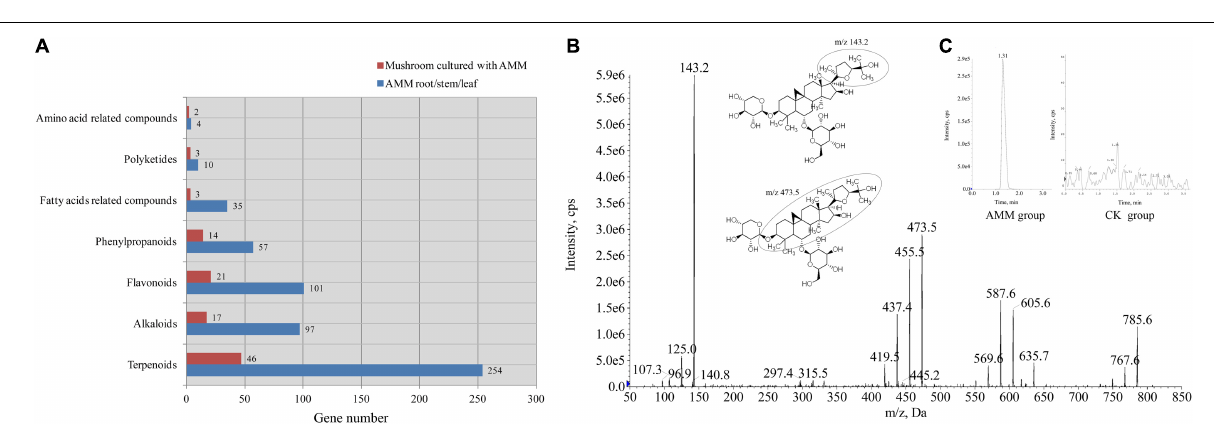
FIGURE 4 | Classification and identification of differential phytometabolites. (A) Differential phytometabolites in our study and major phytometabolites in AMM herbs; (B) product ion mass spectra of [M + H] + ion of astragaloside IV; and (C) chromatography peak of a representative AMM (1.31 min, astragaloside IV) and control